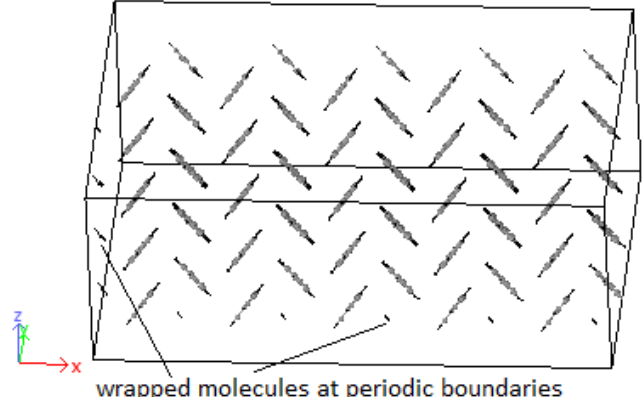
Figure 9. Supercell with wrapped molecules at periodic boundaries.